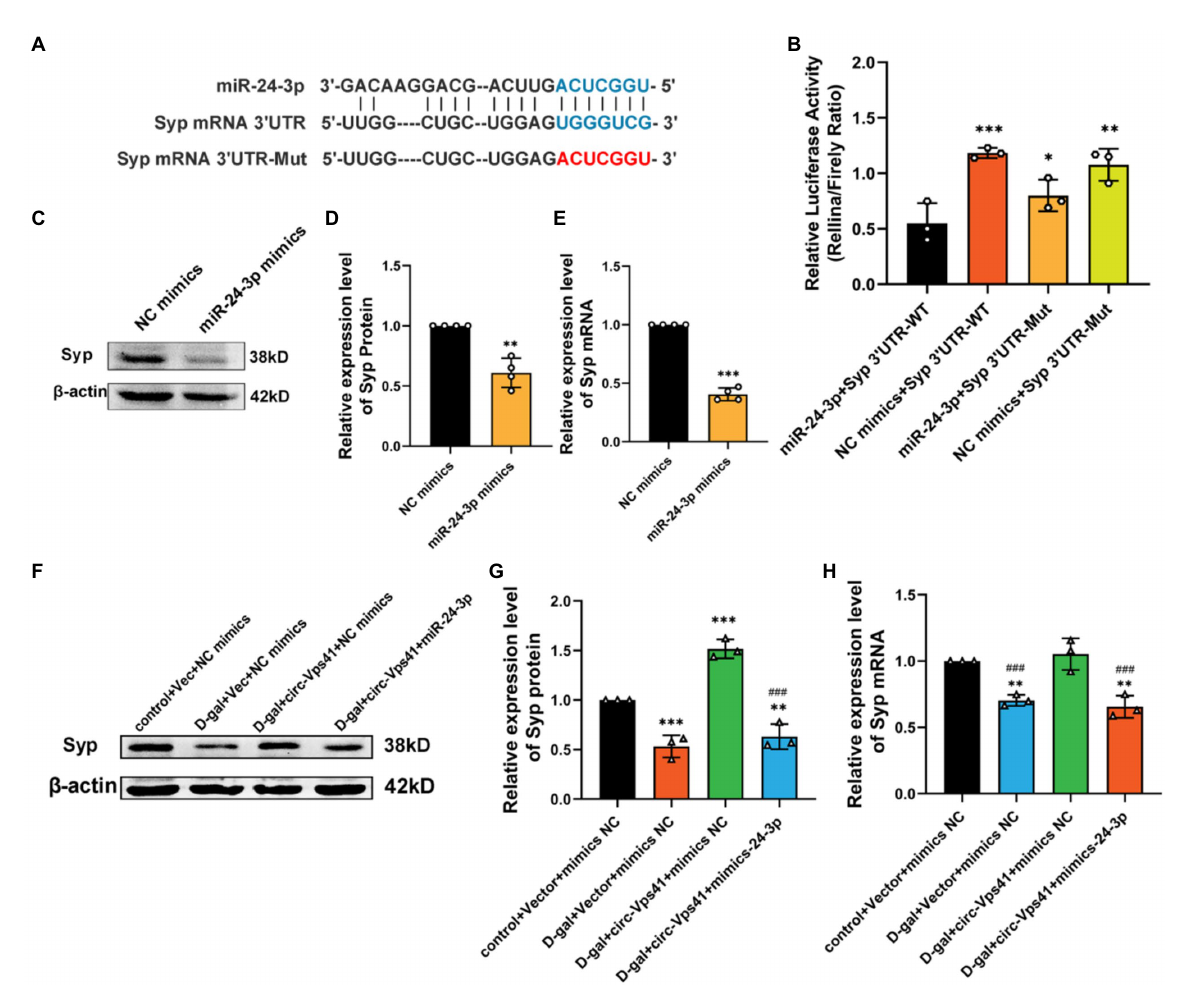
FIGURE 5 Circ-Vps41 improves Syp expression depending on miR-24-3p. (A) Predicted binding sites of miR-24-3p in the Syp mRNA 3 ′ UTR, and the mutation sequence is shown in red. (B) The regulatory effect of miR-24-3p on the expression of miR-24-3p was verified by dual-luciferase reporter gene detection. (C,D) Representative images and quantification of Syp after the overexpression of miR-24-3p in HT22 cells were tested by western blot. (E) The expression level of Syp mRNA was tested by qRT–PCR after the overexpression of miR-24-3p in HT22 cells. The NC mimics group was normalized to 1. (F,G) Representative images and quantification of Syp were tested by western blot after cotransfecting Vec-circ-Vps41 and miR- 24-3p mimics into HT22 cells treated with D-galactose. (H) The expression level of Syp mRNA was tested by qRT-PCR after cotransfecting Vec- circ-Vps41 and miR-24-3p mimics into HT22 cells treated with D-galactose. * p < 0.05, ** p < 0.01, *** p < 0.001 vs. control + Vector + mimics NC group; # p < 0.05, ## p < 0.01, ### p < 0.001 vs. D-gal+circ-Vps41 + mimics NC group; The control + Vector + mimics NC group was normalized to 1. Data are shown as the mean ± SEM. p values, two-tailed t -test, one-way ANOVA. * p < 0.05, ** p < 0.01, *** p <